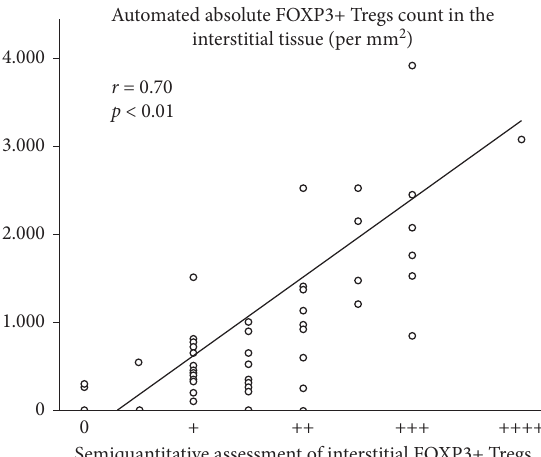
Figure 5: Line diagram of the correlation between interstitial FOXP3+ Tregs automated counting with image analysis software and semiquantitative assessment by an independent pathologist (in a scale from 0 to ++++). Correlation coefficient r was 0.70 ( p < 0 . 01) between the two methods denoting satisfying agreement. r : Pearson’s correlation coefficient and Tregs: regulatory T